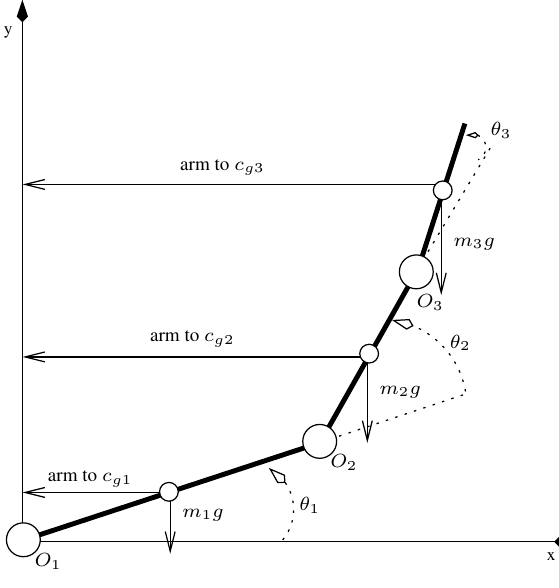
Fig. 4. GRAVITY FORCES DIAGRAM FOR THE PROXIMAL Figure 4. Gravity forces diagram for the proximal